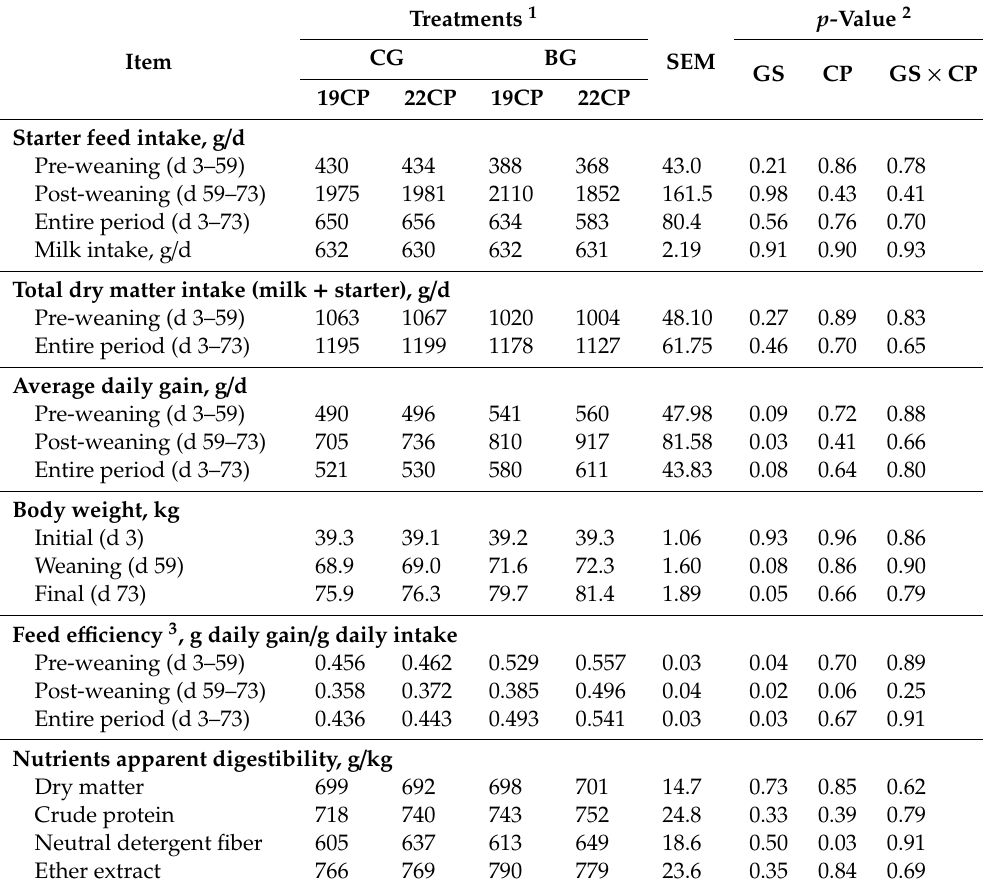
Table 2. Least square means for starter intake, average daily gain, feed e ffi ciency, and nutrient digestibility in dairy calves fed di ff erent grain sources (corn grain vs. barley grain) and di ff erent protein levels (19% vs. 22 % of DM) ( n = 10 calves per